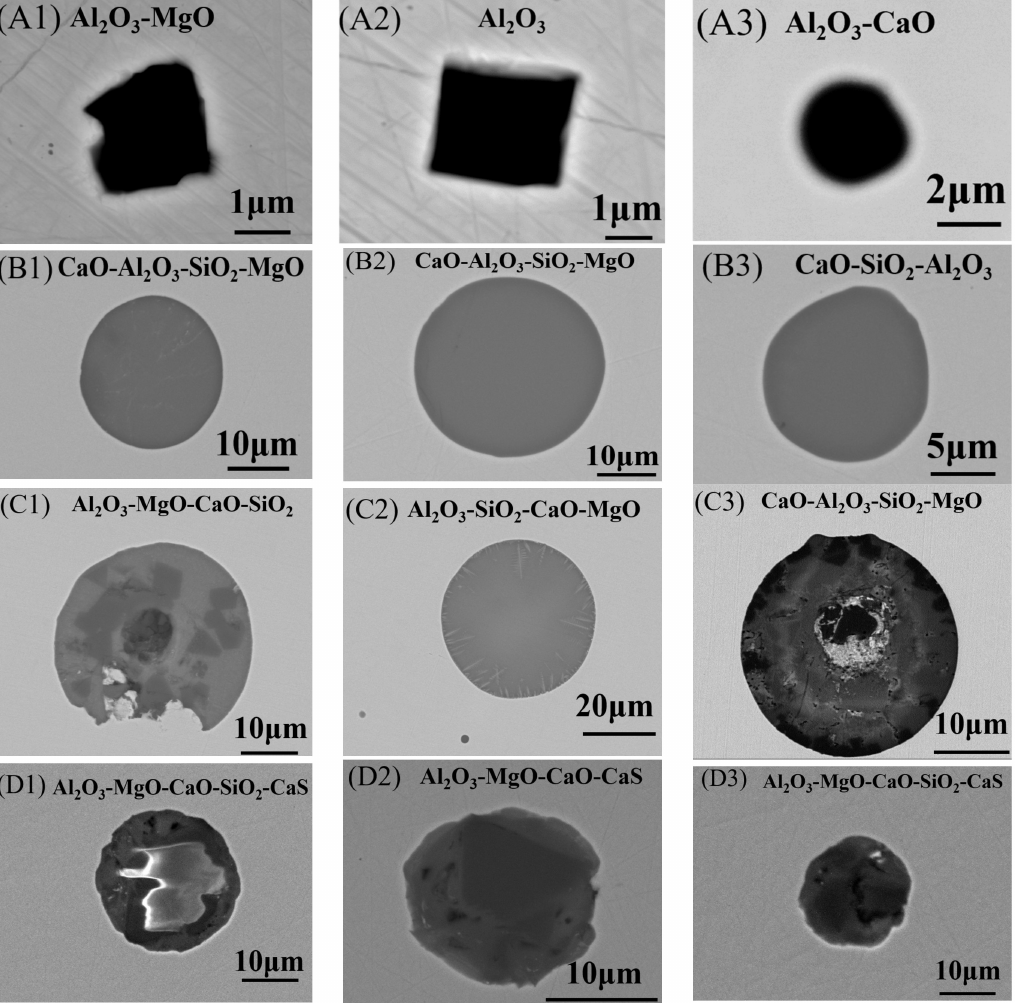
Figure 2. Morphology and main components of typical inclusions in samples ( A1 – A3 ) VD-end, ( B1 – B3 ) LF-end, ( C1 – C3 ) VC-onset, and ( D1 – D3 )